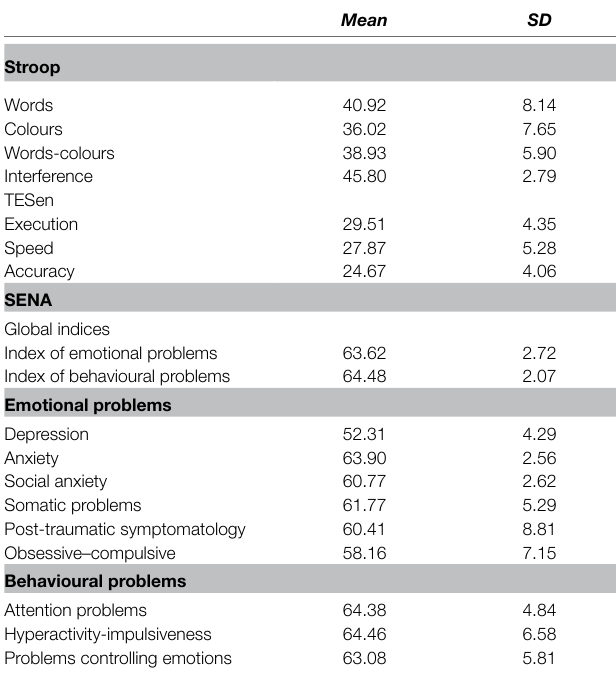
TABLE 1 | Means and SDs of the Stroop, TESen, and System of Evaluation for Children and Adolescents (SENA). Mean